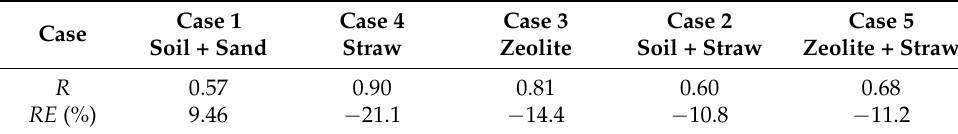
Table 4. Statistical parameters for NH 4+ -N concentration simulation.